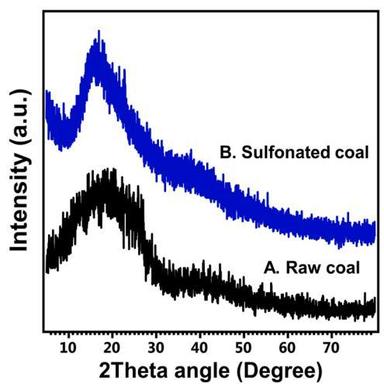
Shows the XRD patterns of raw coal (A) and sulfonated coal at the best acid concentration (95 %) (B).